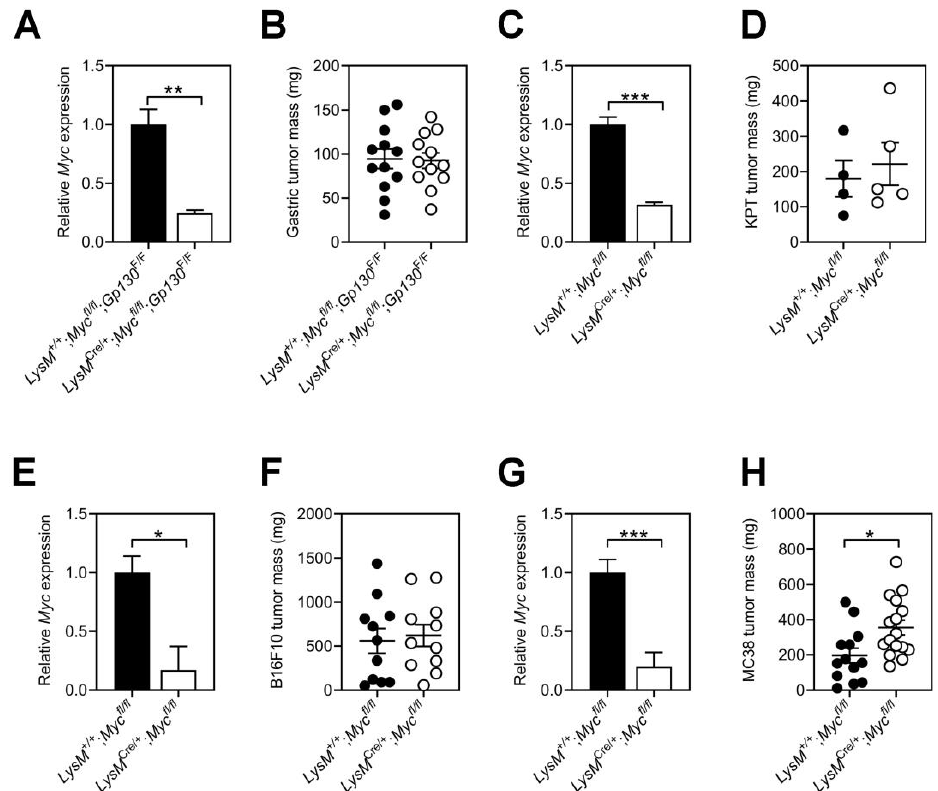
Figure 2. Tumor growth remains refractory to Myc ablation in host macrophages. ( A ) Myc gene expression in gastric tumors of LysM +/+ ; Myc fl/fl ; Gp130 F/F and LysM Cre/+ ; Myc fl/fl ; Gp130 F/F mice. n = 4 mice per group. ( B ) Mass of gastric tumors in LysM +/+ ; Myc fl/fl ; Gp130 F/F and LysM Cre/+ ; Myc fl/fl ; Gp130 F/F mice collected at 100 days of age. Each symbol represents an individual mouse. n = 12 mice per group. ( C ) Myc gene expression in subcutaneous KPT gastric tumor organoids of LysM +/+ ; Myc fl/fl and LysM Cre/+ ; Myc fl/fl hosts. n = 4 mice per group. ( D ) Mass of subcu- taneous KPT gastric tumor organoids from LysM +/+ ; Myc fl/fl and LysM Cre/+ ; Myc fl/fl hosts. Mice were collected at 3 weeks following tumor organoid injection. Each symbol represents an individual mouse. n ≥ 4 mice per group. ( E ) Myc gene expression in TAMs isolated from subcutaneous B16F10 tumors of LysM +/+ ; Myc fl/fl and LysM Cre/+ ; Myc fl/fl hosts. n ≥ 3 mice per group. ( F ) Mass of subcutaneous B16F10 tumors from LysM +/+ ; Myc fl/fl and LysM Cre/+ ; Myc fl/fl hosts. Mice were collected at 2 weeks following tumor cell injection. Each symbol represents an individual mouse. n = 11 mice per group. ( G ) Myc gene expression in TAMs isolated from subcutaneous MC38 tumors of LysM +/+ ; Myc fl/fl and LysM Cre/+ ; Myc fl/fl hosts. n ≥ 3 mice per group. ( H ) Mass of subcutaneous MC38 tumors from LysM +/+ ; Myc fl/fl and LysM Cre/+ ; Myc fl/fl hosts. Mice were collected at 2 weeks following tumor cell injection. Each symbol represents an individual mouse. n ≥ 13 mice per group. Data represent mean ± SEM; * p < 0.05, ** p < 0.01, *** p < 0.001, with statistical significance determined by an unpaired Student’s t